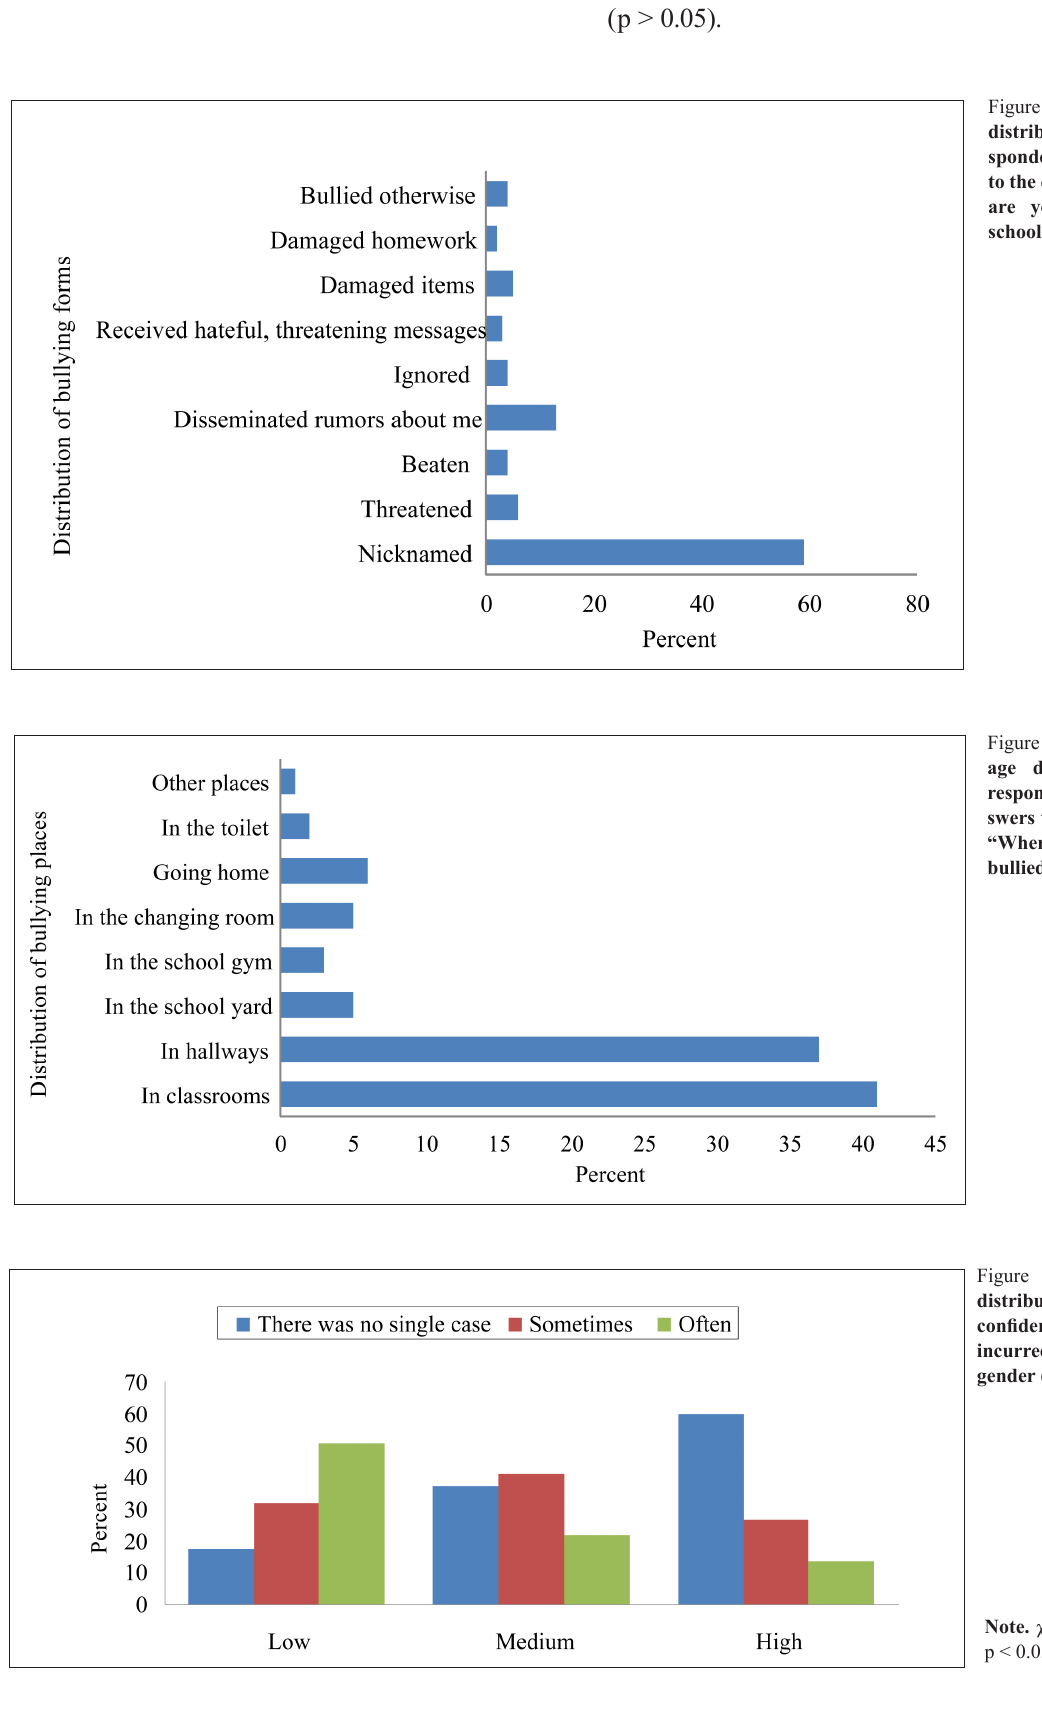
are you bullied at